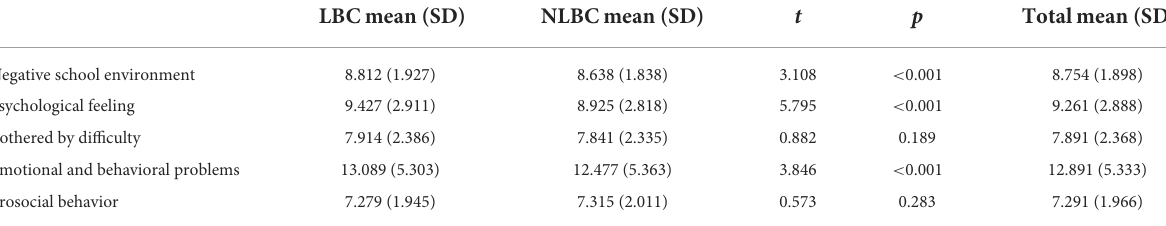
TABLE 3 Comparison of negative school environment, negative psychological feeling, emotional and behavior difficulties, bothered by difficulties of LBC and